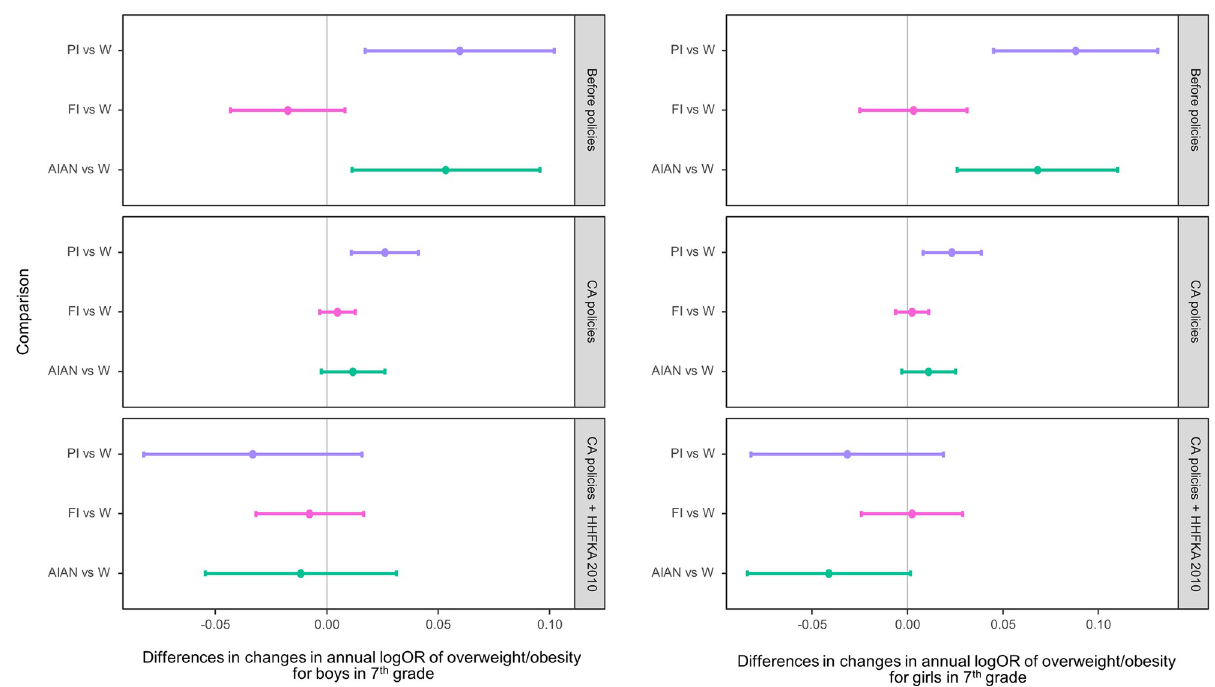
Fig 5. Racial/ethnic differences in adjusted changes in the log odds of overweight/obesity per year comparing the periods 2002–2004 (baseline, no policies in effect), 2005–2012 (after CA policies and before HHFKA 2010), and 2013–2016 (CA policies plus HHFKA 2010) among seventh graders by sex. The dots indicate the point estimates of the yearly changes in the log odds, and the whiskers show the 95% confidence intervals. AIAN, American Indian/Alaska Native; CA, California; FI, children of Filipino origin; HHFKA 2010, Healthy, Hunger-Free Kids Act of 2010; OR, odds ratio; PI, children of Pacific Islander origin; W,